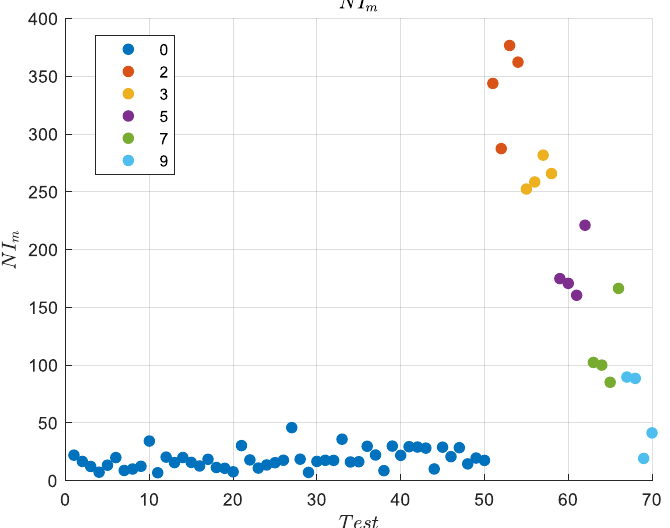
Figure 5. Mahalanobis Distance NI m . Healthy conditions of the machinery are indicated as Class 0, while the damage is defined as Class k , where k = 2, 3, 5, 7, 9.